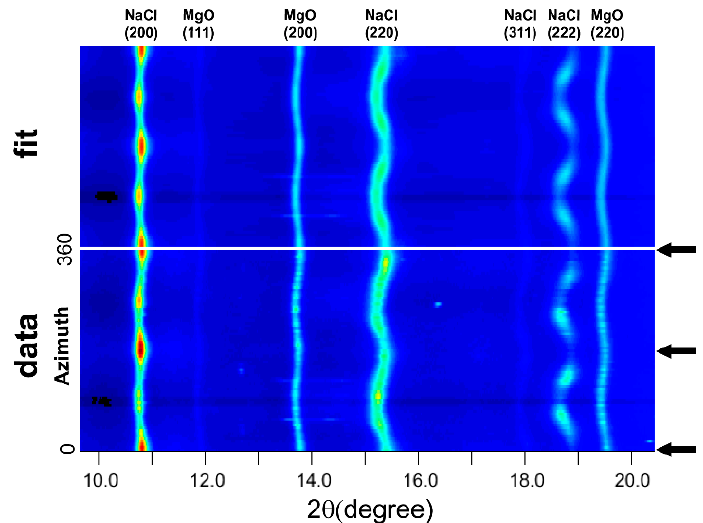
Figure 1. An unrolled diffraction image and materials analysis using diffraction (MAUD) fit of the 20% MgO + 80% NaCl sample. Black arrow indicates the compression direction. Sinusoidal distortion of diffraction line indicates lattice strain. Systematic intensity variation along azimuth indicates texture.